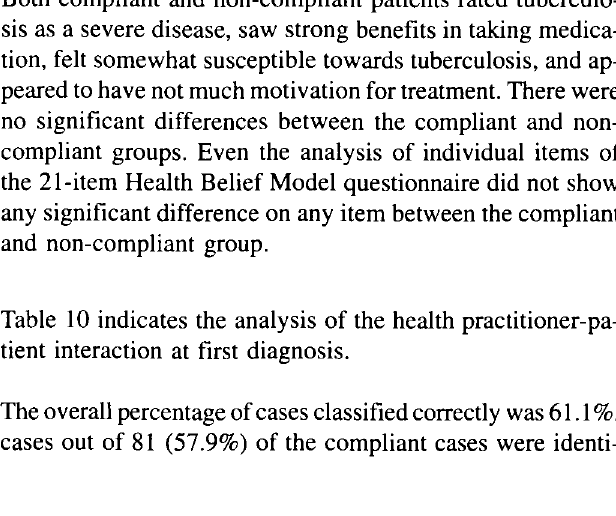
Table 9 indicates the components of the Health Belief Model regarding tuberculosis.